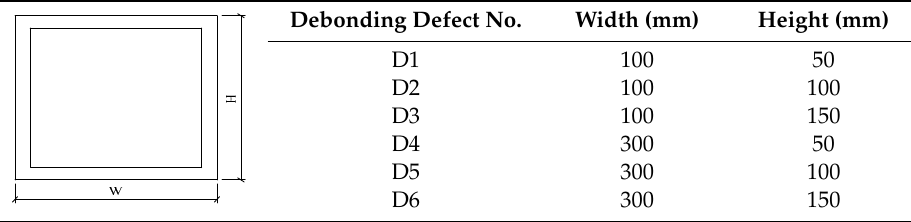
Table 1. Geometric parameters of the artificially mimicked interface debonding defects. Debonding Defect No.